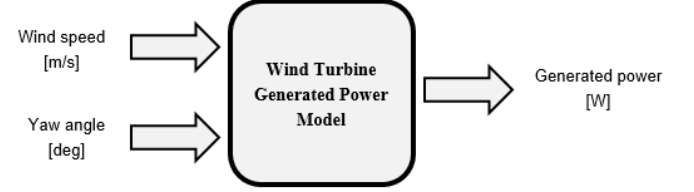
Figure 3. Wind turbine generated power model.